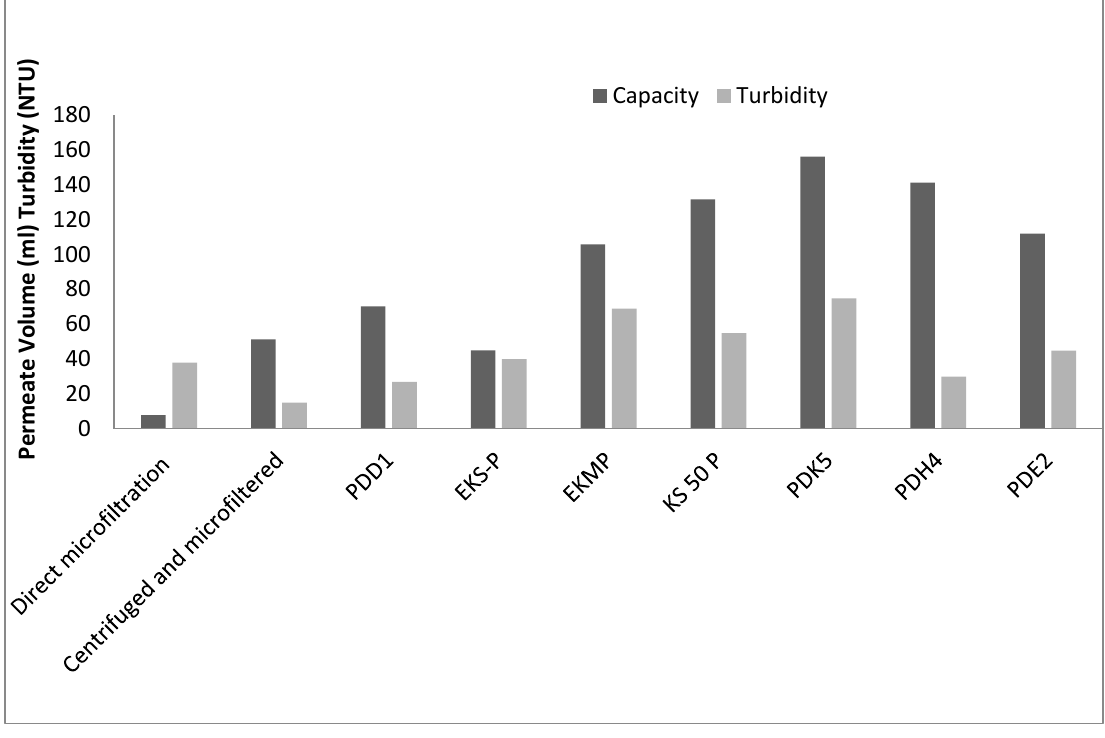
Figure 4. Volume vs. time data for individual models fit against the filter data for